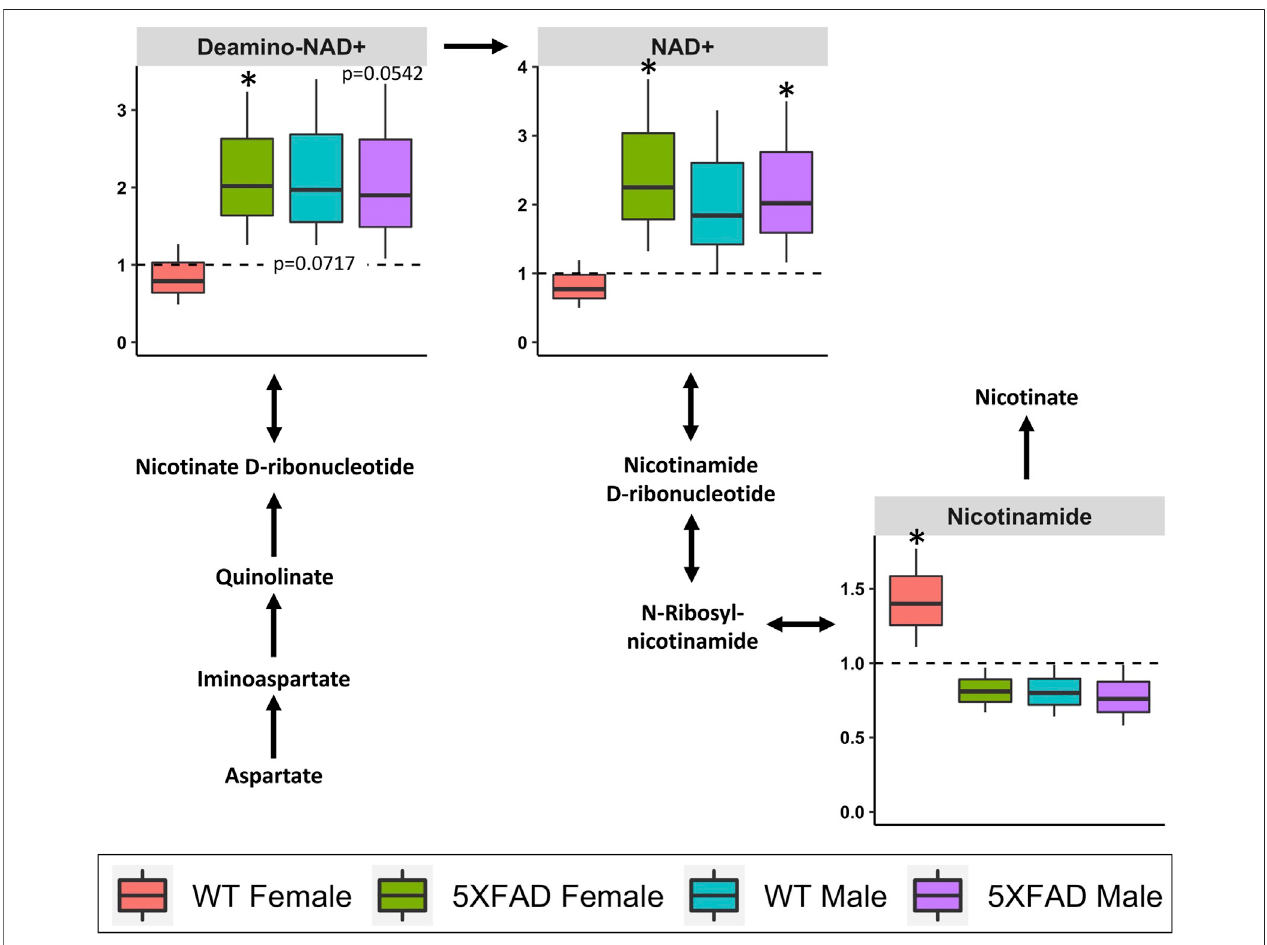
FIGURE 8 | Fold changes in cortical metabolites related to nicotinate and nicotinamide metabolism in male and female 5xFAD or wild-type (WT) mice following treatment with CAW (500 mg/kg) compared to sex- and genotype-matched untreated controls. * p < 0.05, ** p < 0.005, *** p < 0.001.